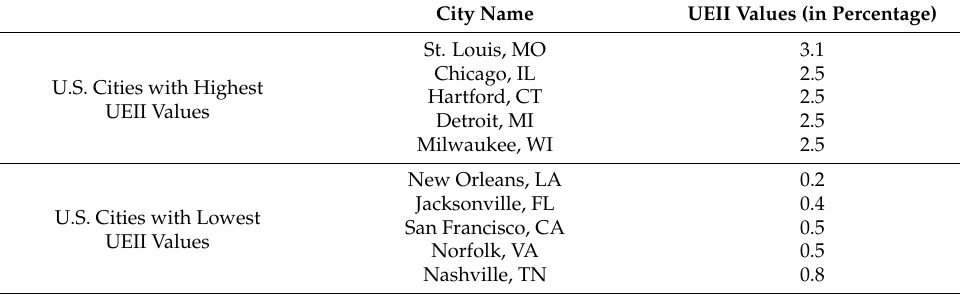
Table 6. Top and bottom five U.S. cities with the highest and lowest UEII